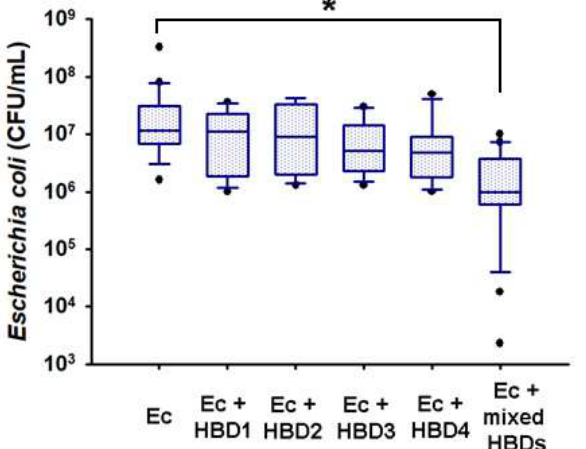
Figure 6. Microbicidal effect of recombinant HBDs upon Escherichia coli growth. A constant load of bacteria (1 × 10 5 CFU/mL) was incubated in the presence of 2000 ng/mL of each recombinant defensin alone or combined (500 ng/mL HBD-1 + 500 ng/mL HBD-2 + 500 ng/mL HBD-3 + 500 ng/mL HBD-4) in antibiotic-free medium. Incubations proceeded at 37 °C for 4 h. The E. coli control repre- sents the normal bacteria growth in the absence of antimicrobial peptides. The data are presented as boxes (25th, 50th, and 75th percentile) and whiskers (5th and 95th percentile). n = 4–8 independent experiments in triplicate. Ec = Escherichia coli. * p < 0.05.